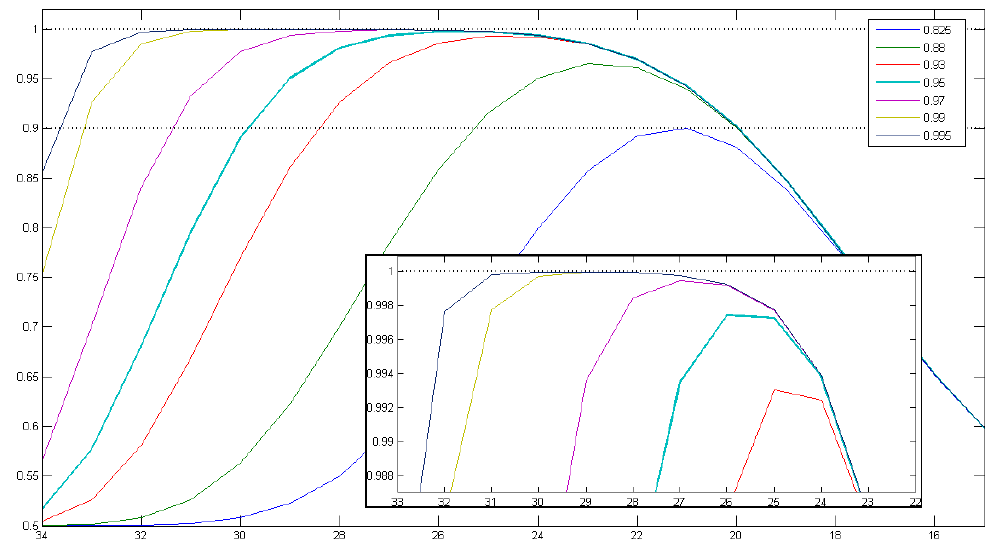
Figure 16: Evolution of the success rate τ ( S ( c )) (ordinate) in function of c (abscissa) for different probabilities p (colors). A zoom is drawn in the